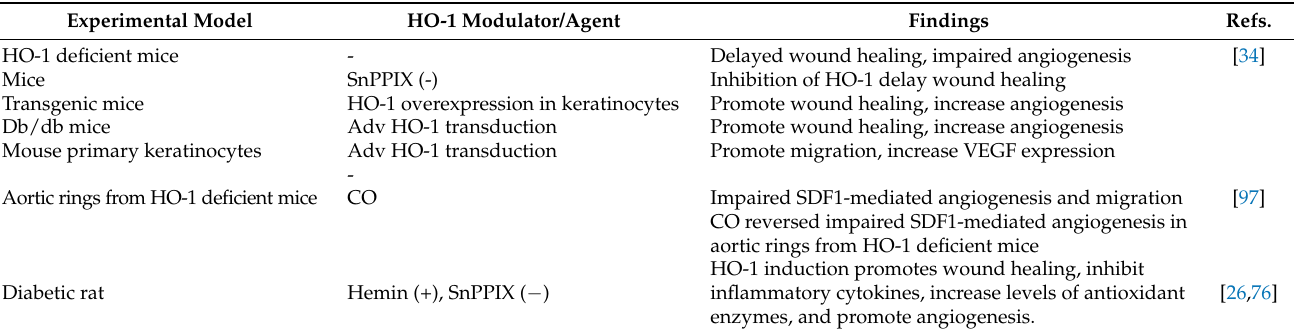
Table 2. Studies supporting the role of HO-1 in wound